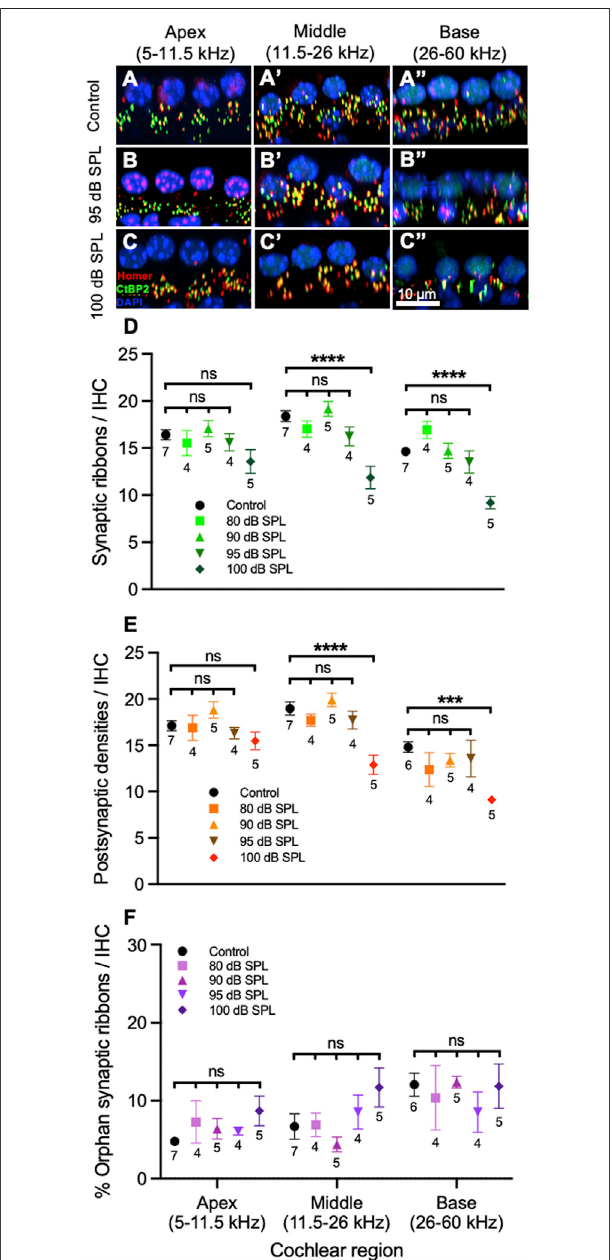
FIGURE2 |betweencontrolmiceandthoseexposedto80,90,or95 dBSPL inanyregionofthecochlea. (E) Quanti fi cationofPSDsperIHC.Miceexposed to100 dBSPLhadreducednumbersofPSDsperIHCinthemiddleandbase of the cochlea when compared with control, unexposed mice. There were no signi fi cant differences in PSDs per IHC between control mice and those exposedto80,90,or95 dBSPLinanyregionofthecochlea. (F) Comparison of the percentage of orphan ribbons (without an associated PSD) per IHC between mice exposed to different noise intensities. There were no signi fi cant differencesinthepercentageoforphanribbonsperIHCbetweencontrolmice and those exposed to 80, 90, 95 or 100 dB SPL in any region of the cochlea. Data points represent means and error bars indicate standard error. Sample sizes are displayed under each data point and expressed in number of mice. All ribbon, PSD, and percentage of orphan ribbon counts per IHC represent averages of both the right and left ears when available. ns (cid:1) not signi fi cant, *** p < 0.001, **** p <